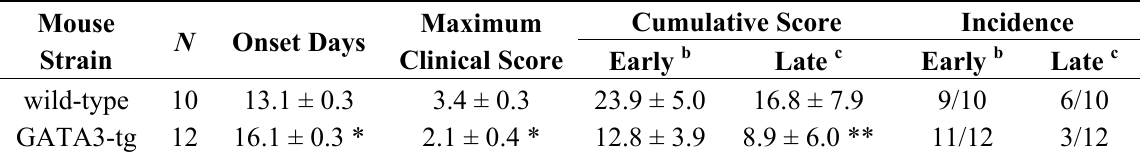
Table 1. Clinical signs of experimental autoimmune encephalomyelitis (EAE) in wild-type and GATA3-tg mice a .